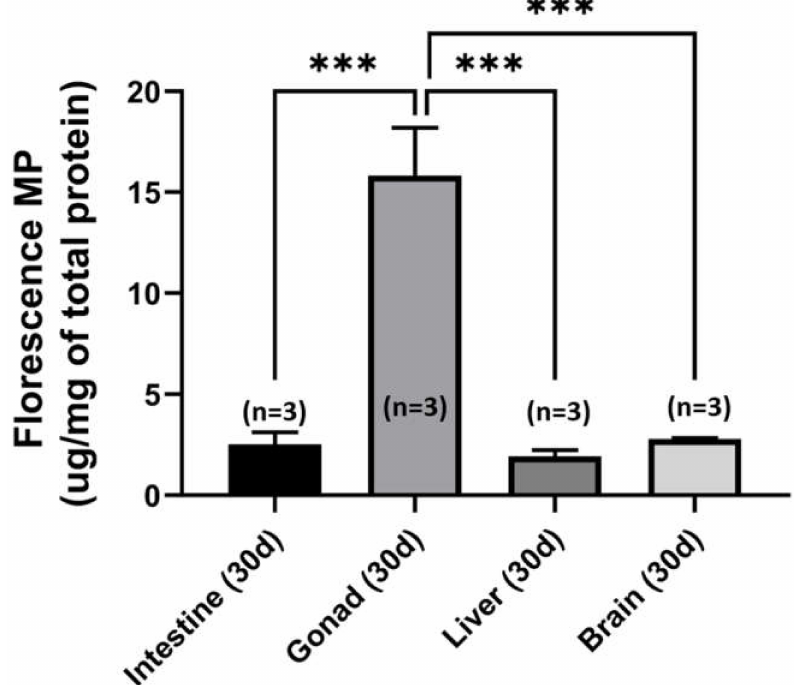
Figure 8. Comparison of the tissue distribution of green fluorescence-labeled nanoplastics among di ff erent tissues in zebrafish after ~30 days of polystyrene nanoplastics (PS-NPs) exposure. The data are expressed as the mean ± SEM and they were analyzed by One-way ANOVA, which continued with post hoc analysis ( n = 3; *** p <